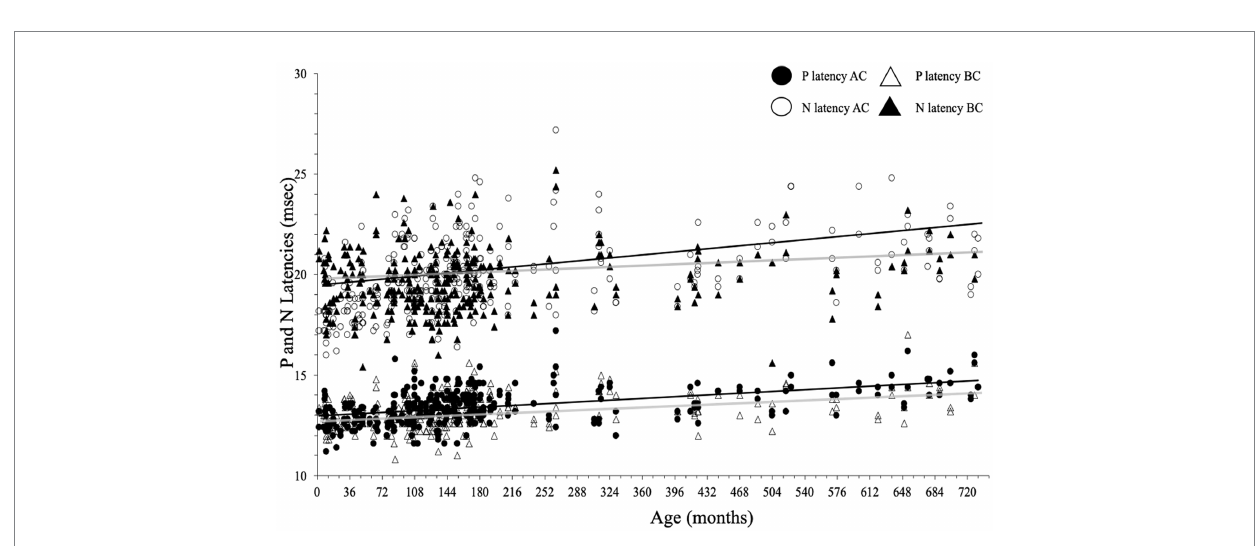
FIGURE 10 P- and N-wave latencies as a function of age for air conduction (AC) and bone conduction (BC). Regression lines (Spearman) are gray for BC and black for